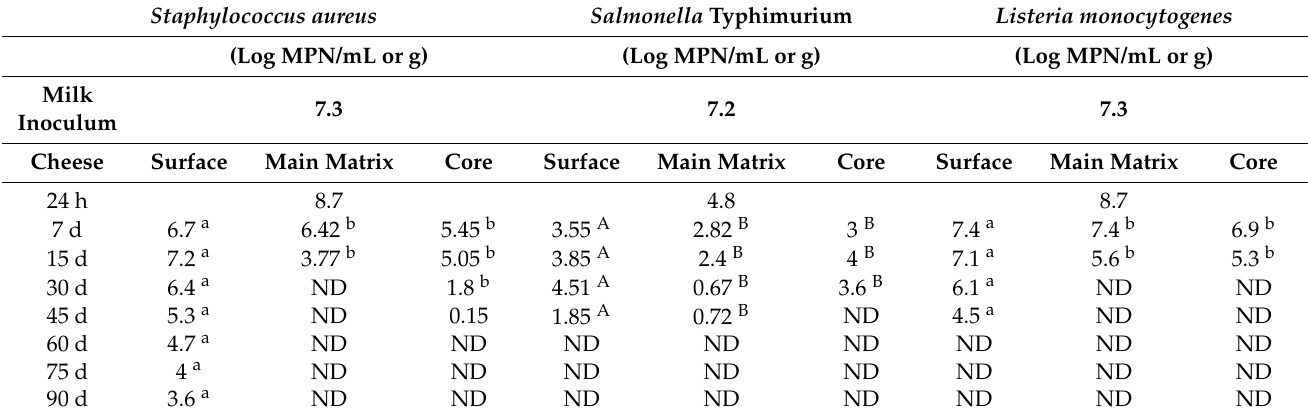
Table 2. Behavior of pathogens in Cotija cheese made with inoculated milk. Staphylococcus aureus Salmonella Typhimurium Listeria monocytogenes